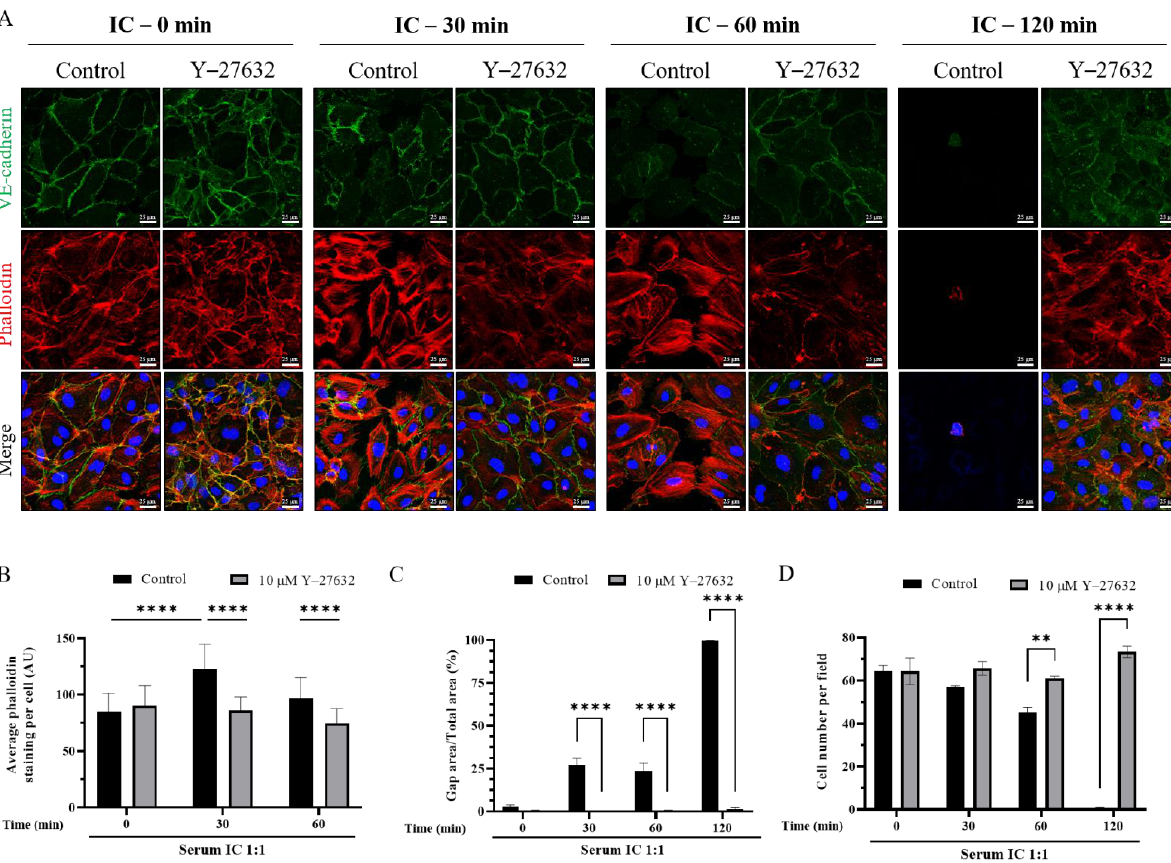
Figure 6. Endothelial barrier disruption by IC was prevented by treatment with ROCK inhibitor Y-27632. Type O HPAEC were pre-treated with 10 µ M ROCK inhibitor (Y-27632) before injury with concentrated serum-derived IC 1:1 with media. ( A ) Cells were stained with anti-VE-Cadherin antibody (green) to mark AJs, Phalloidin-594 (red) to visualize actin stress fibers, and DAPI (blue) for nuclei. ( B ) Mean fluorescence intensity of actin stress fibers (phalloidin staining) per cell was determined. Values are reported in arbitrary units (AU) and analyzed by two-way ANOVA. The 120 min time point was excluded from statistical calculations due to low cell number in the Control group. ( C ) Gap formation between cells was measured by calculating the area without cell coverage in each field normalized to the total area of the field. ( D ) The number of cells per field was quantitated and averaged for each treatment. Data are mean + S.E. (n = 3 fields per condition) and were analyzed by two-way ANOVA. p -values as follows: ** p < 0.01; **** p <